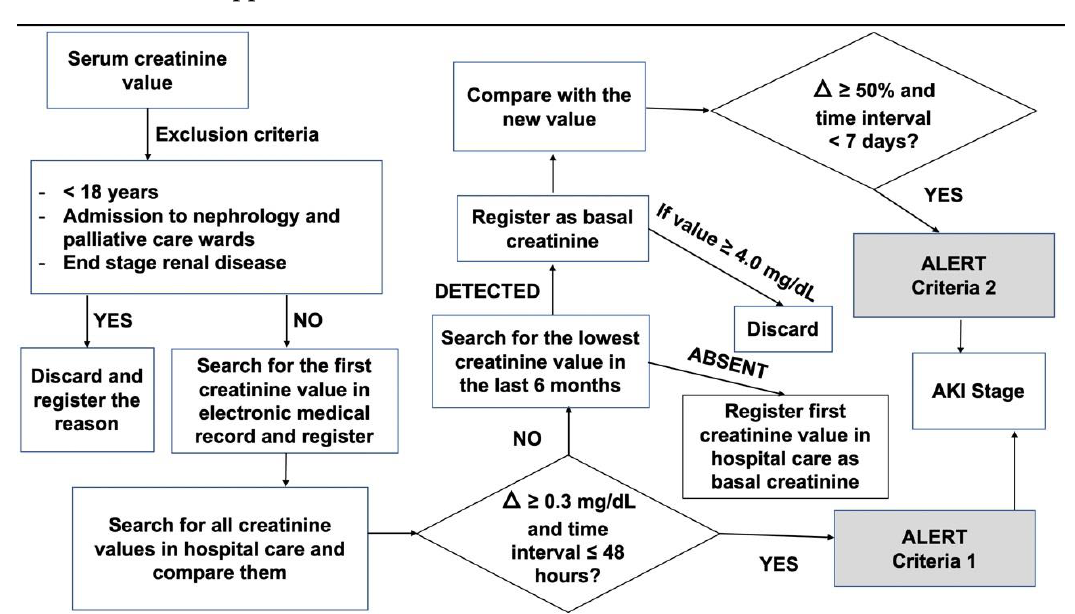
Figure A1. Flowchart detailing the electronic AKI alert code.